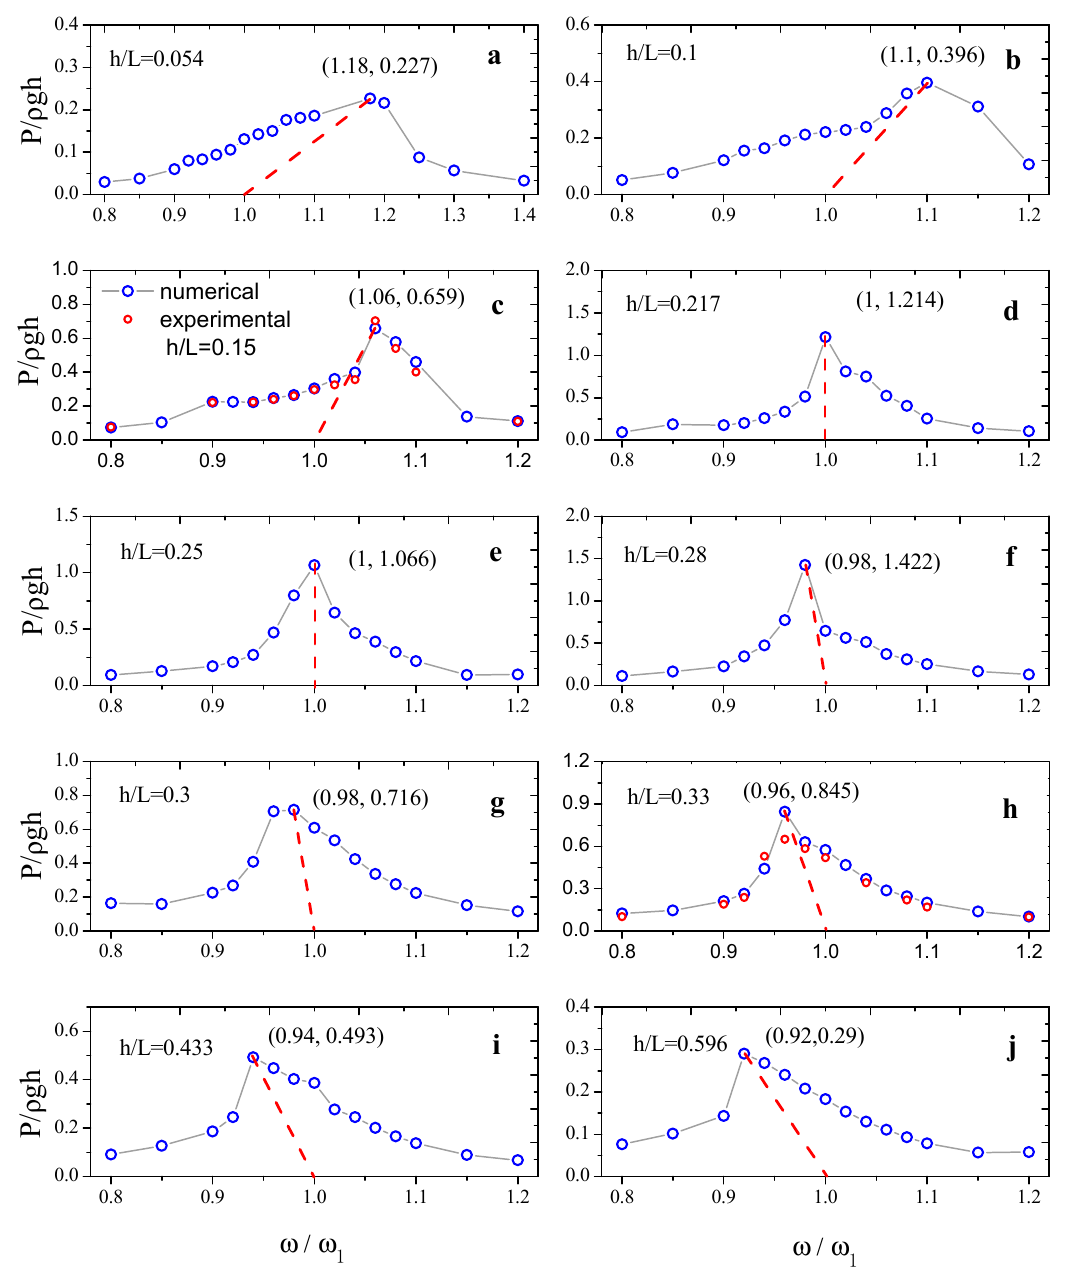
Figure 16. The pressure–frequency response curves at different filling levels. ( a ) h/L = 0.054, ( b ) h/L = 0.1, ( c ) h/L = 0.15, ( d ) h/L = 0.217, ( e ) h/L = 0.25, ( f ) h/L = 0.28, (g) h/L = 0.3, (h) h/L = 0.33, ( i ) h/L = 0.433, ( j ) h/L = 0.596.